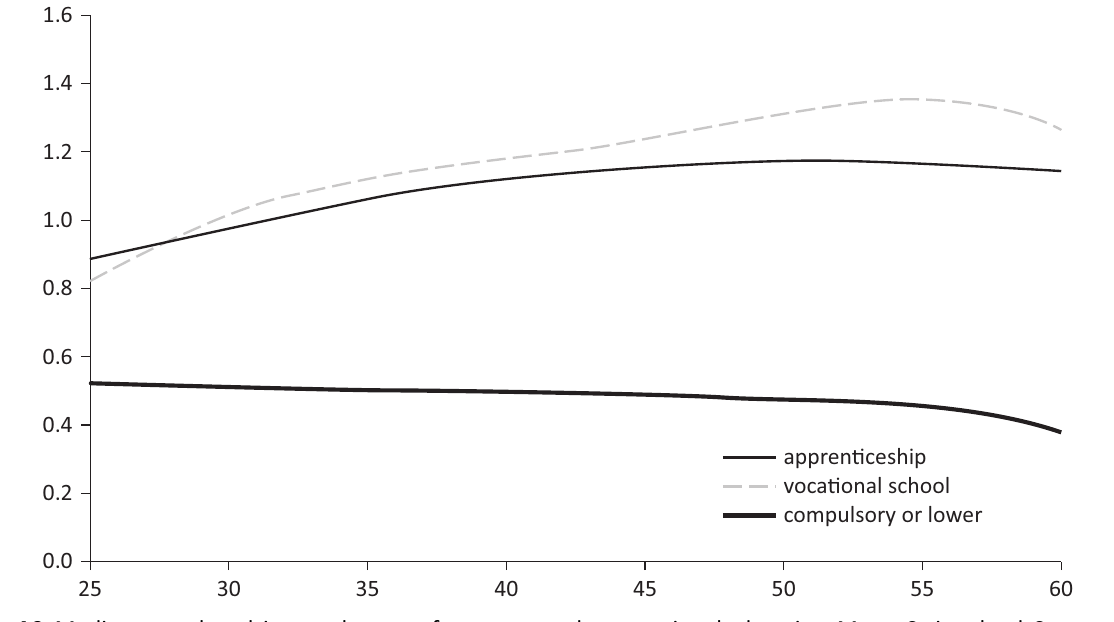
Figure A9. Median annual work income by type of upper-secondary vocational education. Men—Switzerland. Source: Swiss Labour Force Survey 1991–2014. Note: 1 = Median annual work income for CH (CHF72,300).